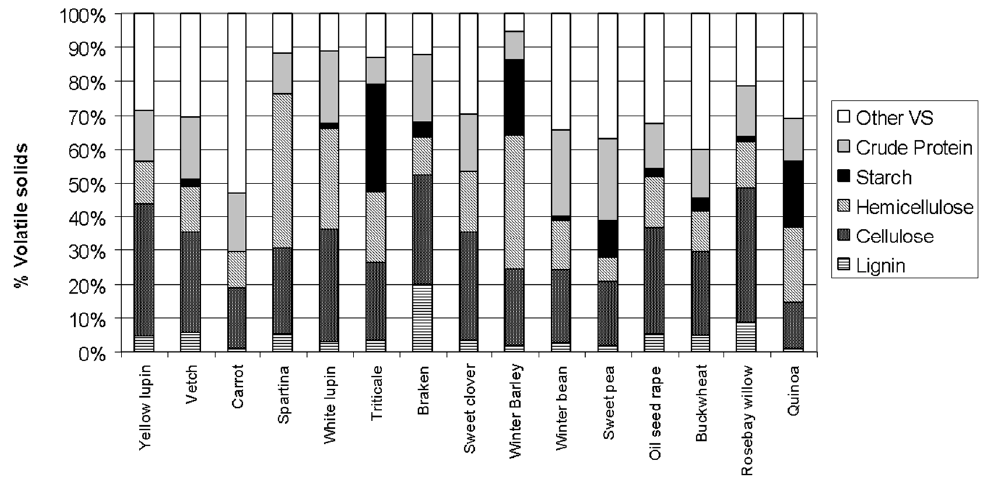
Figure 1. Volatile Solids composition of the 15 European plant samples evaluated.